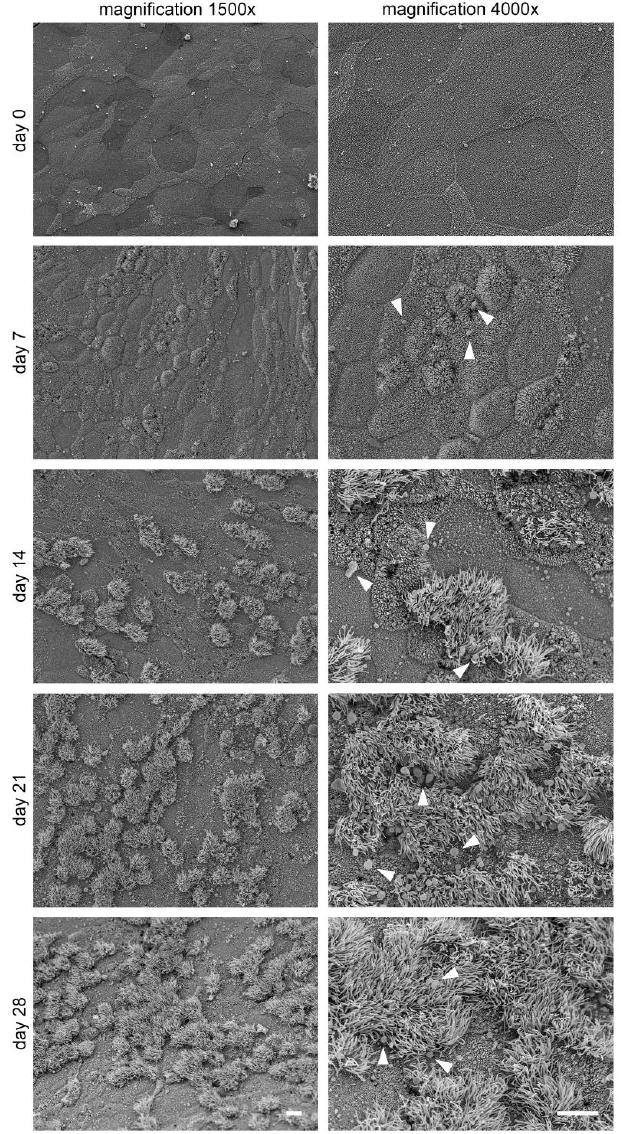
Figure 5. Scanning electron microscopic (SEM) assessment of cilia differentiation in tracheal epithelial cells under air–liquid interface (ALI) conditions over time. Representative pictures are shown of ALI cultures at days 0, 7, 14, 21, and 28. At day 0, undifferentiated tracheal epithelial cells were present with a flat, apical surface. Increasing numbers of ciliated cells were seen over the culture period starting from day 7 up to day 28. Cilia were arranged in individual bundles on the surface of epithelial cells, often along with numerous microvilli that were also frequently present. Additionally, SEM revealed the presence of mucus globules (arrowheads) starting from day 7. Pictures in the left column are taken at 1500 × and in the right column at 4000 × magnification. Scale bars represent 10 µ